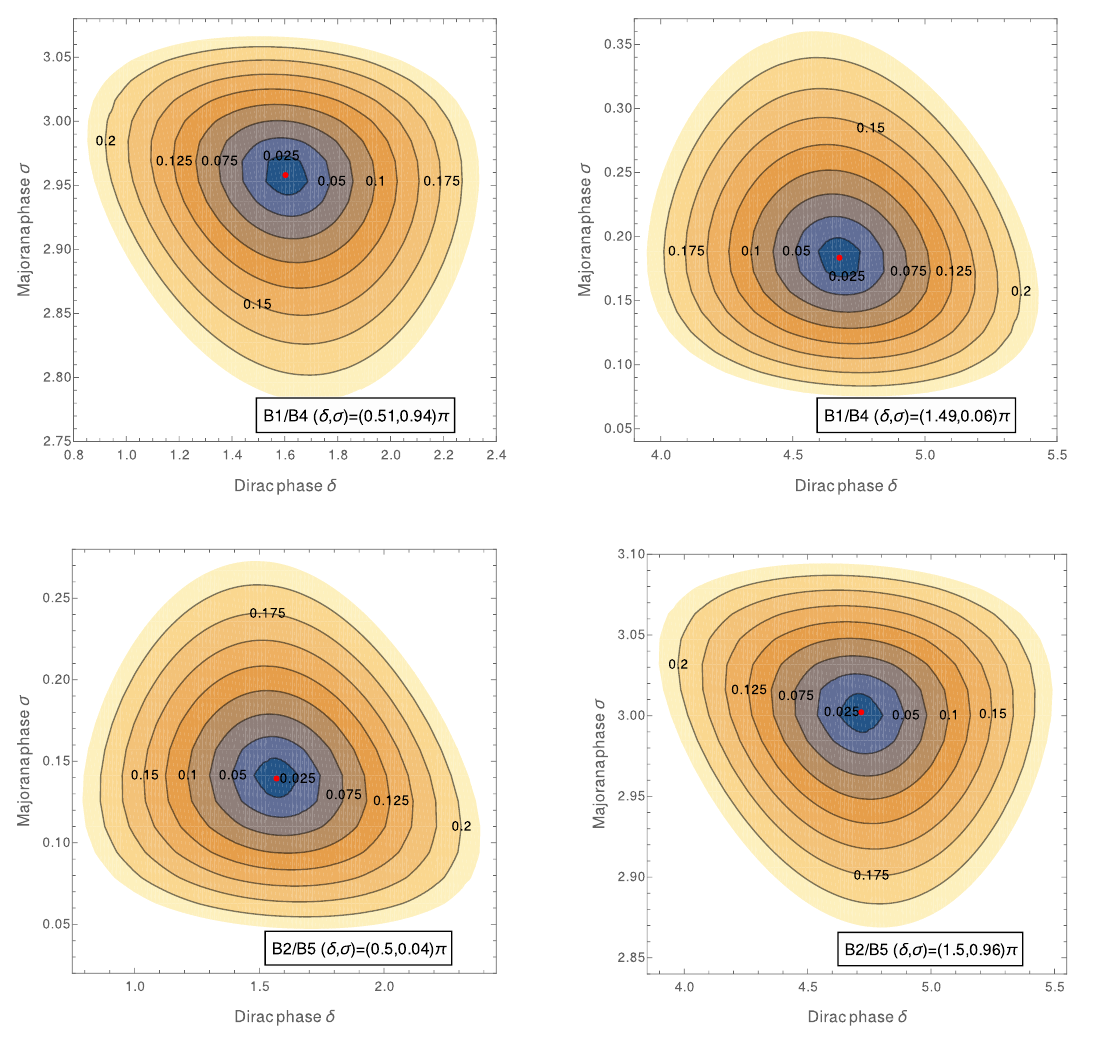
Figure 5 . Minimized hierarchy parameter H 23 as a function of (cid:14) and (cid:27) in the vicinity of its exact zeros (in the case of an inverted mass ordering), see eq. (2.18). For both possible two-zero textures, B 1 ; 4 and B 2 ; 5 , we respectively (cid:12)nd two zeros in the ( (cid:14); (cid:27) ) plane, which are related to each other via the re(cid:13)ection symmetry in eq.